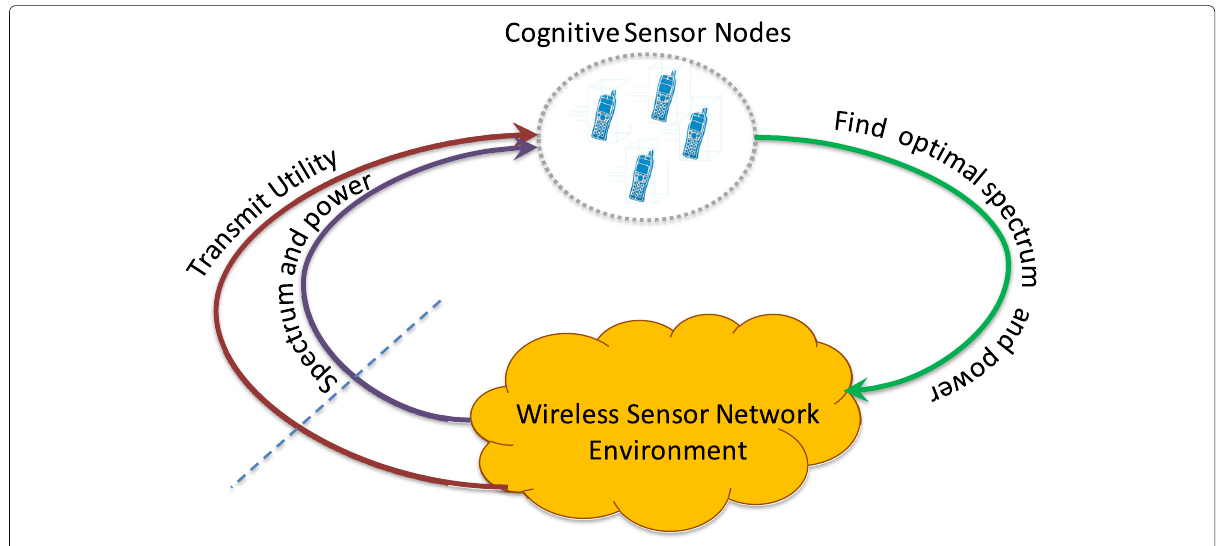
Fig. 1 Multi-agent learning framework for typical